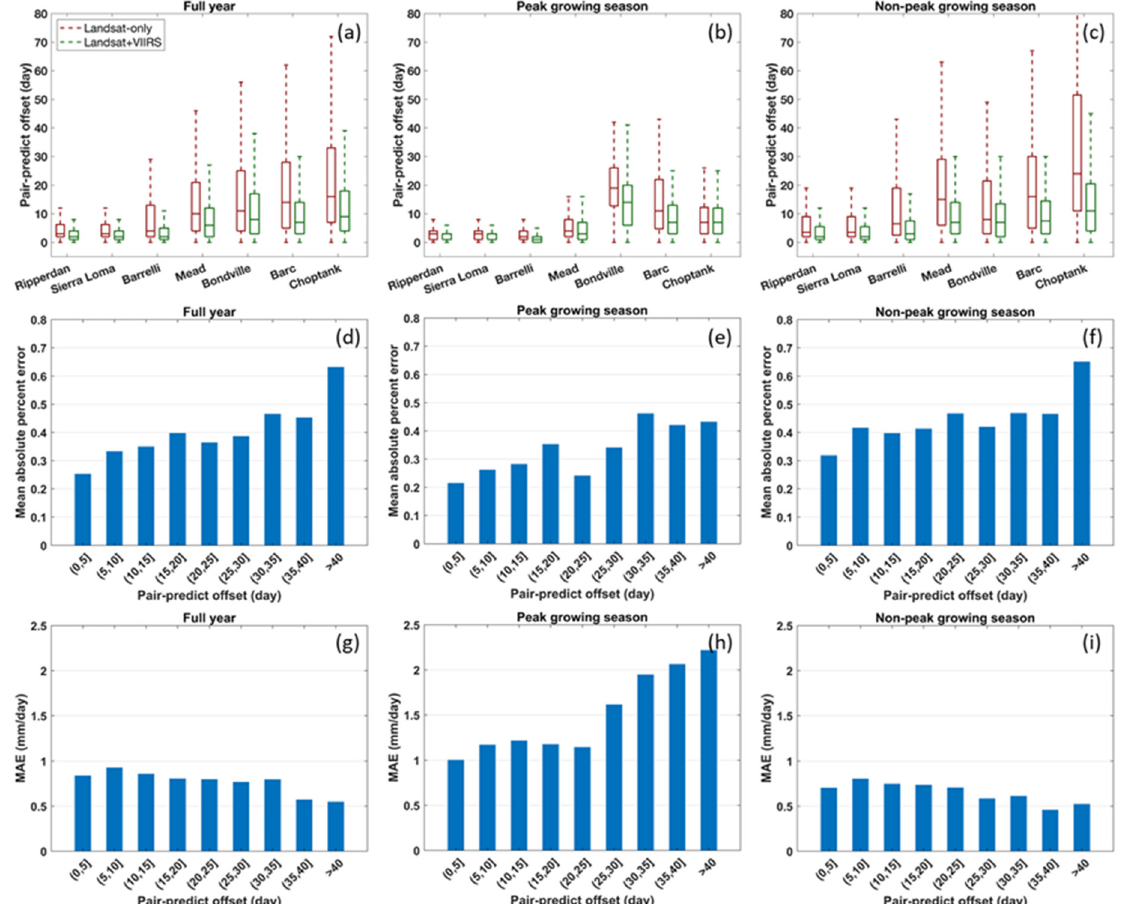
Figure 9. Boxplot of offset (in days) between direct retrieval date and prediction date over each domain for ( a ) the full year, ( b ) the peak growing and ( c ) non-peak growing season. Fusion accuracy in terms of mean absolute percent error (MAE/<O>) as a function of offset days between input and target dates for ( d ) the full year, ( e ) the peak growing and ( f ) non-peak growing season. <O> is the mean of the observed ET. ( g – i ) Same as ( d , f ), but for MAE (mm d − 1 ). Note that the fusion accuracy plots are from the Landsat-only fusion timeseries.